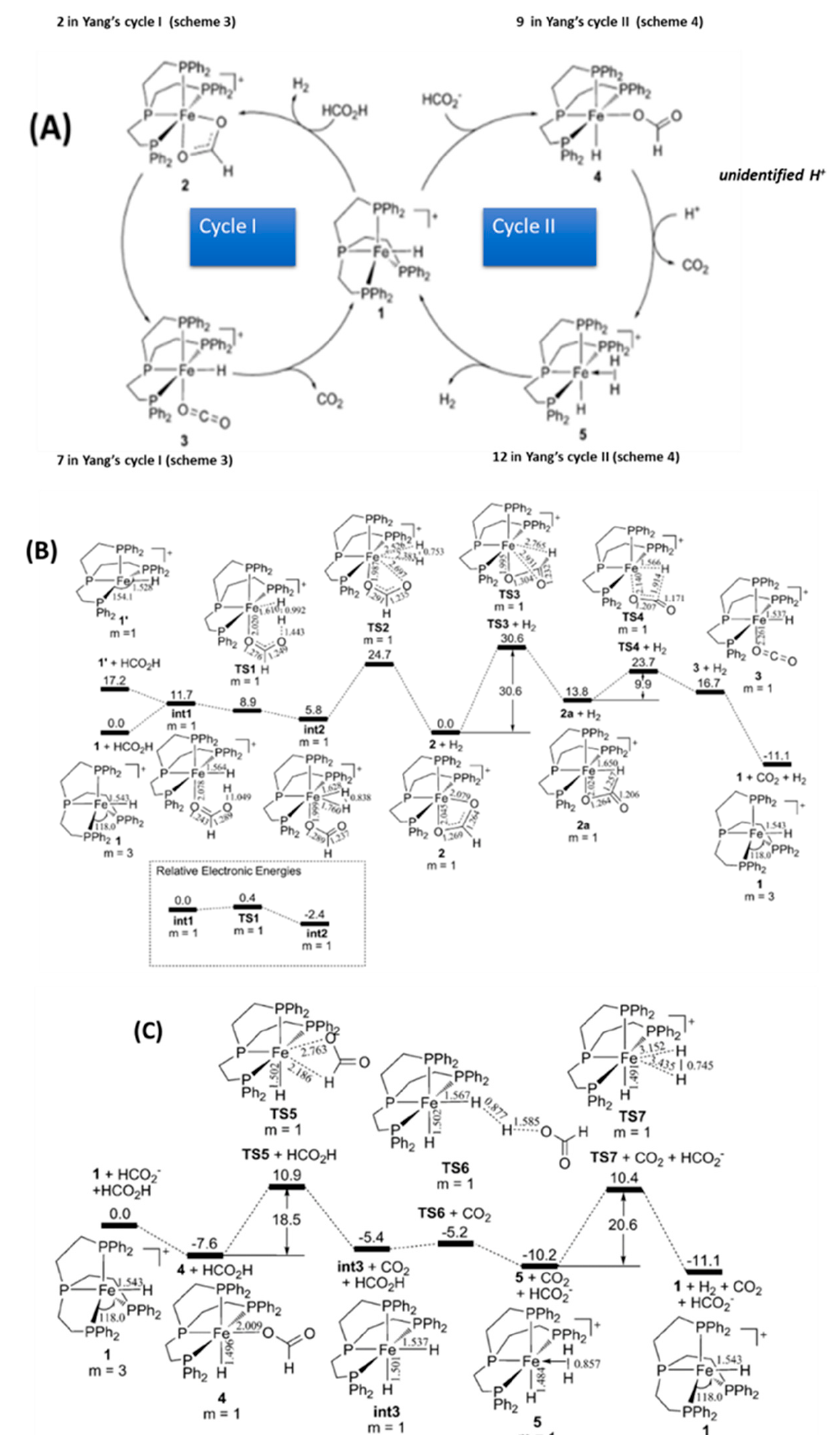
Figure 5. Catalytic Cycle-I and Cycle-II ( A ) and the energetic profiles as calculated by Ahlquist et al. [53]; ( B ) the transient intermediates for cycle-I and ( C ) the transient intermediates for cycle II. Figure adapted from Reference [53].